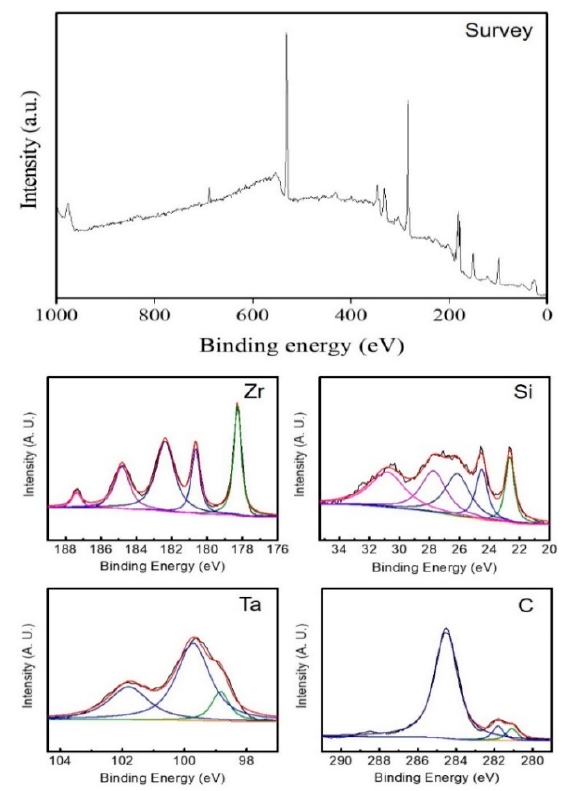
Figure 4. X-ray photoelectron spectroscopy (XPS) of ZrB 2 –SiC–TaC and its constituent compounds.